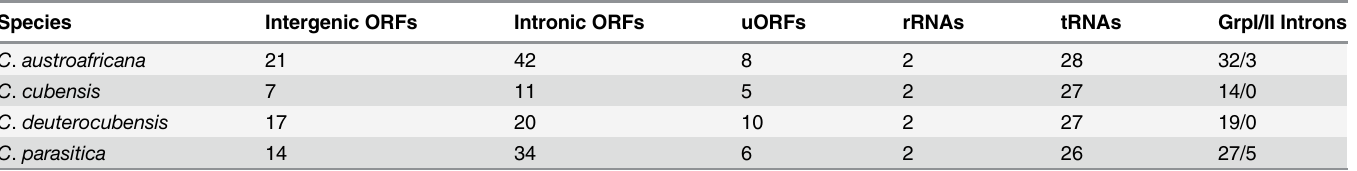
Table 1. Mitochondrial genome features. Number of genes, open reading frames (ORFs), rRNA, tRNAs and introns of the mitochondrial genomes of Chry- soporthe austroafricana , C . cubensis , C . deuterocubensis and Cryphonectria parasitica . Intergenic ORFs were considered uORFs if no HEG domains or sig- nificant BLAST hits could be